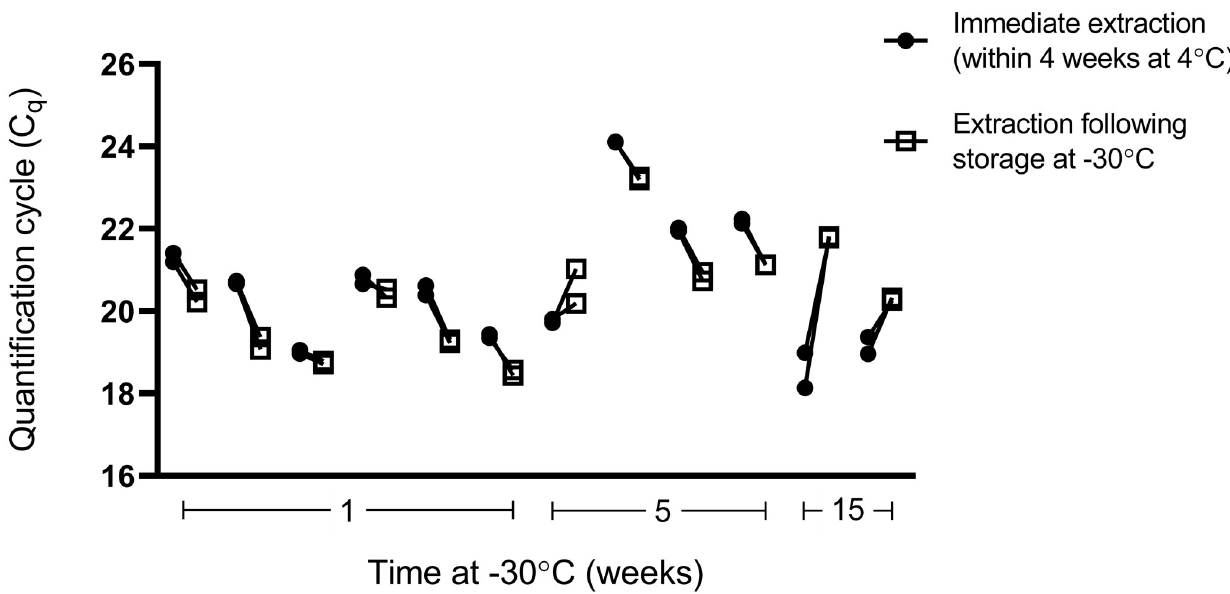
Fig 2. Effects of storing washed stools at -30˚C on DNA. SYBR green qPCR for the vertebrate mitochondrial gene was used to determine DNA integrity following “immediate” extraction from stools (stored 4˚C for � 4 weeks, ● ) versus stools washed and stored at -30˚C ( □ ) for different lengths of time: 1 w (n = 6), 5 w (n = 4) and 15 w (n = 2). Mean C q s and standard deviations are shown for duplicate